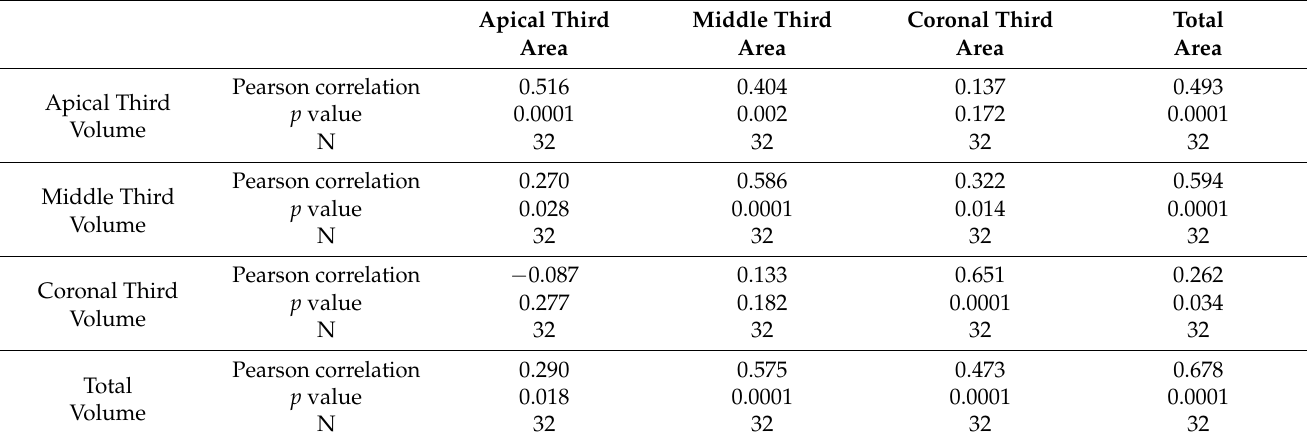
Table 4. Pearson correlation of areas and volumes of SC group ( p value was set at 0.05). Apical Third